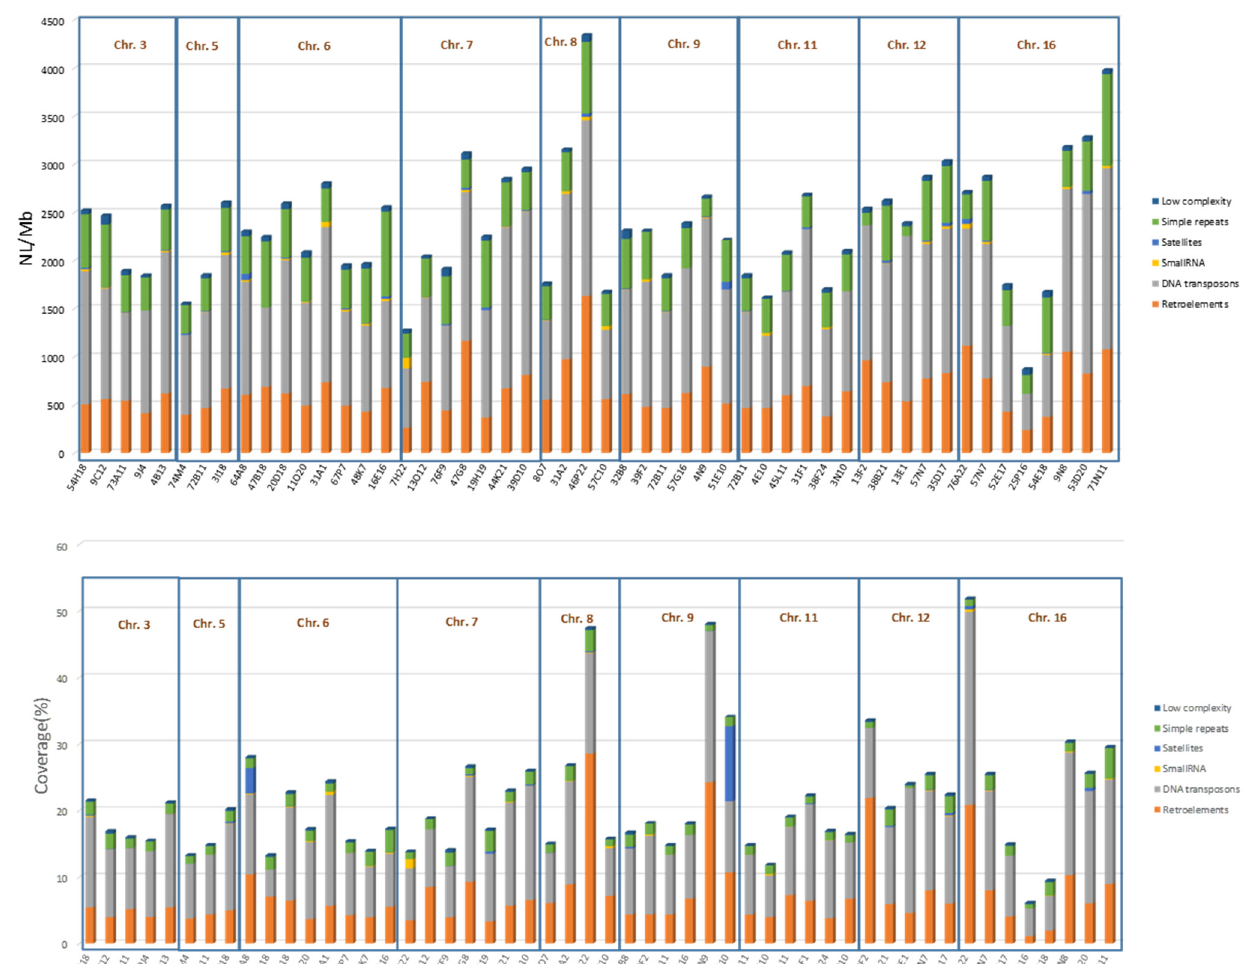
Figure 3. Number of loci per Mb (NL/Mb) and coverage (%) of repeat elements in BACs from chromosomes 3, 5–9, 11, 12 and 16 of Solea senegalensis : DNA transposons, retroelements, small RNA, satellites, simple repeats, low complexity.